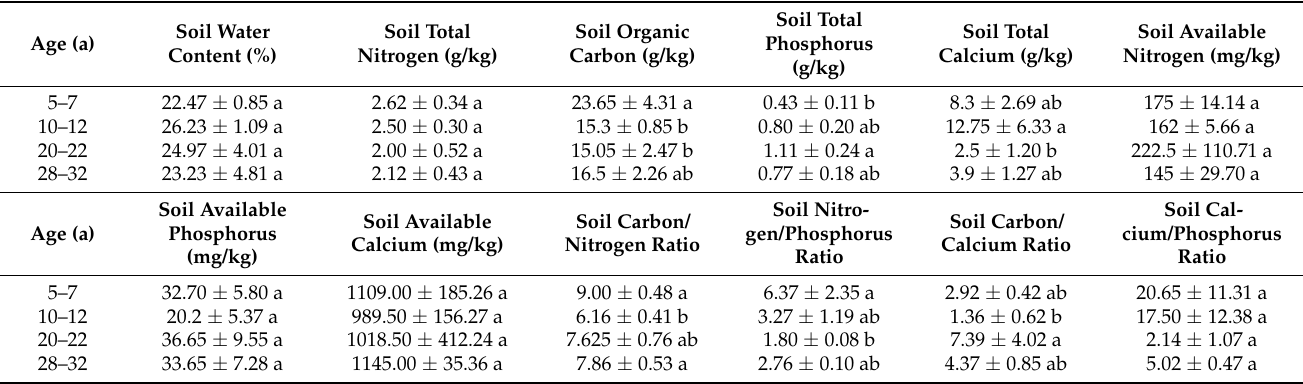
Table 2. Descriptive statistics of soil